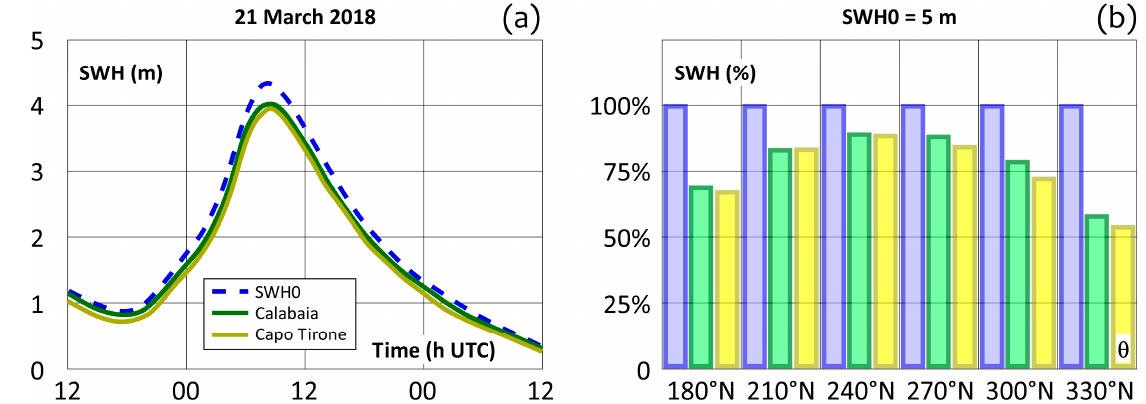
Figure 13. SWH comparison between the seaward boundary condition (SWH0, blue) and the two eligible sections for the deployment of the buoy reported in Figure 11 (Calabaia, green and Capo Tirone, yellow). ( a ) Event of 21 March 2018. ( b ) SWH0 = 5 m and θ from 180 ◦ N to 330 ◦